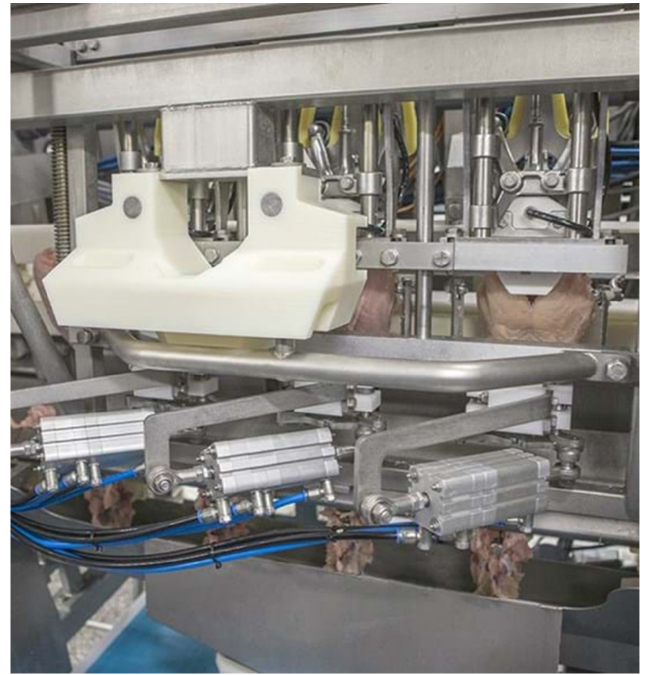
Figure 3. A new generation of automatic breast fillet deboning with the capabilities of measuring the size of each bone-in breast fillet portion to allow adaptive filleting of different size birds. The new generation machines also allow producing a range of products such as half fillets with/without skin, butterfly with/without tenders. Photo courtesy of Marel.